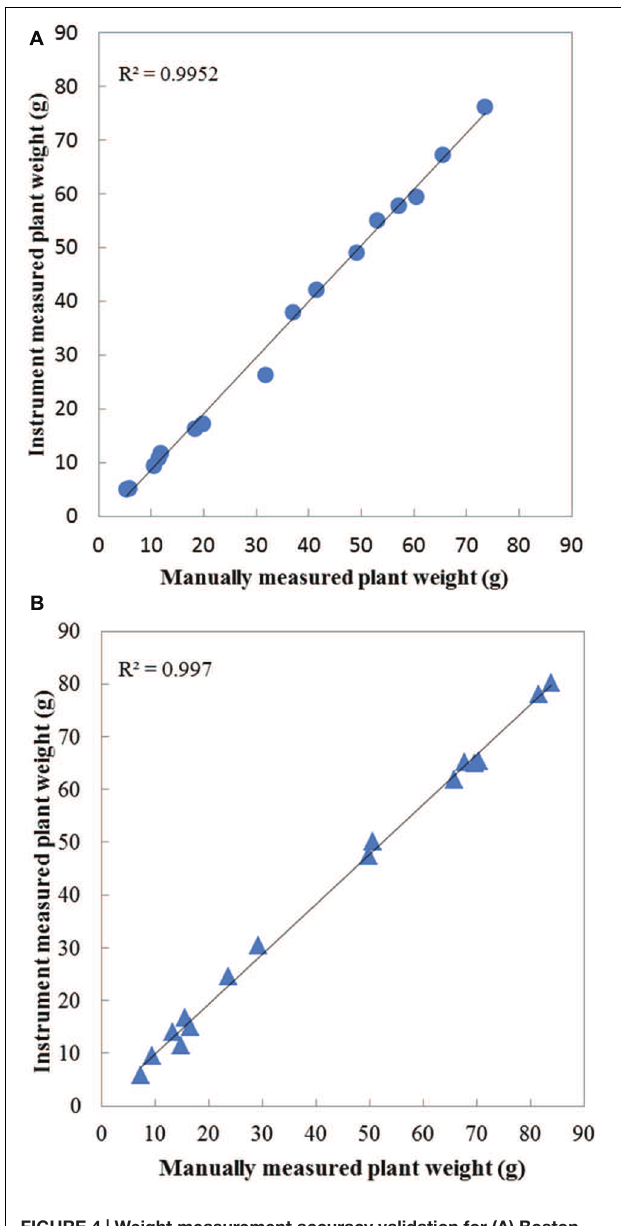
FIGURE 4 | Weight measurement accuracy validation for (A) Boston lettuces (circle) and (B) coral lettuces